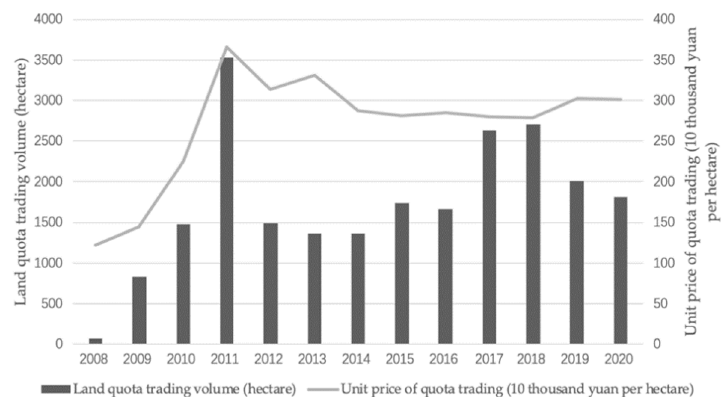
Figure 4. The development of LQT program in Chongqing, China, since 2008.